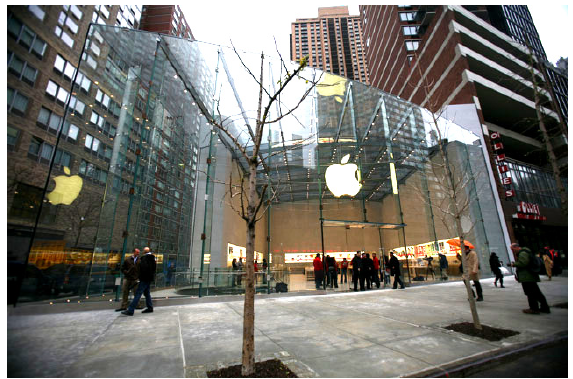
Figure 1: Apple Store, Upper West Side, front